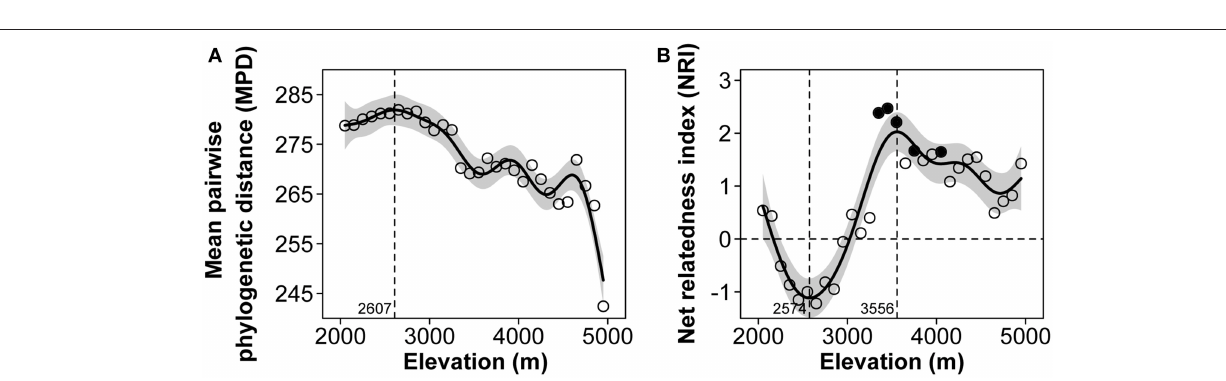
These results are strongly consistent with previous studies that, for a given regional pool, showed that species may respond to environmental gradients in different ways, thus affecting